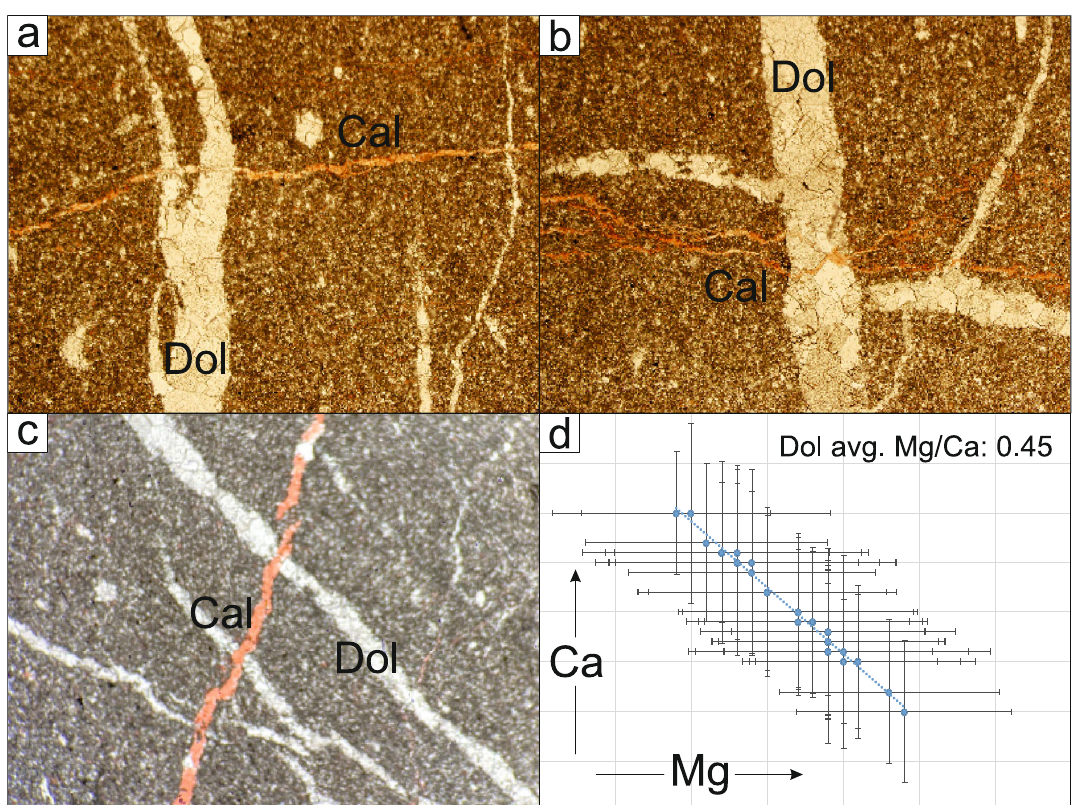
Figure 7. ( a–c ) Transmitted (plane-polarized) light thin-section images of sample JH-1 stained with red- alizarin. ( d ) Calcium vs magnesium ratio of dolomite sample